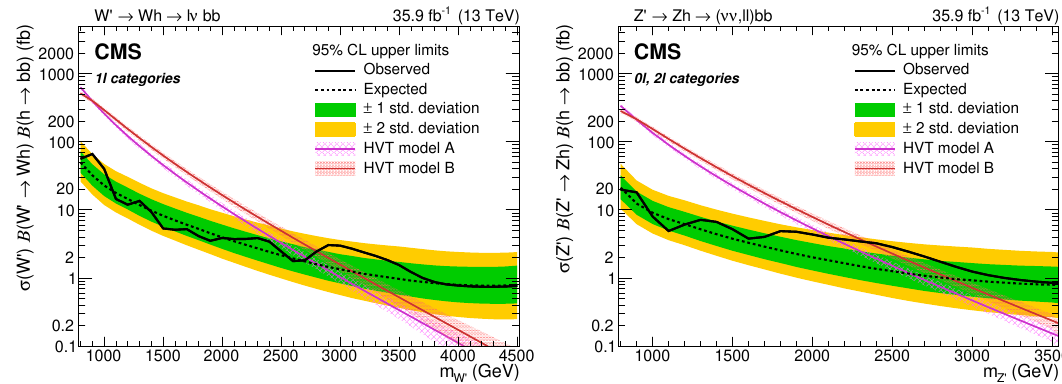
Figure 5 . Observed and expected 95% CL upper limits on (cid:27) (W 0 ) and (cid:27) (Z 0 ) (Z 0 Zh) (h bb) (right) for various mass hypotheses of a single narrow spin-1 B ! B ! resonance. The inner green and outer yellow bands represent the (std.) variations on the expected limits. The solid curves and their shaded areas correspond to the product of the cross sections and the branching fractions predicted by the HVT models A and B and the relative